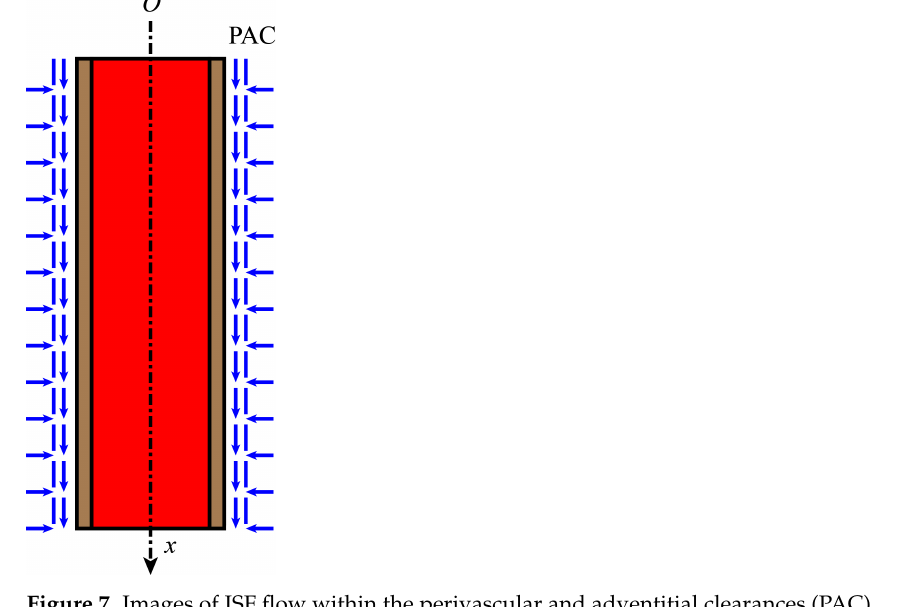
Figure 7. Images of ISF flow within the perivascular and adventitial clearances